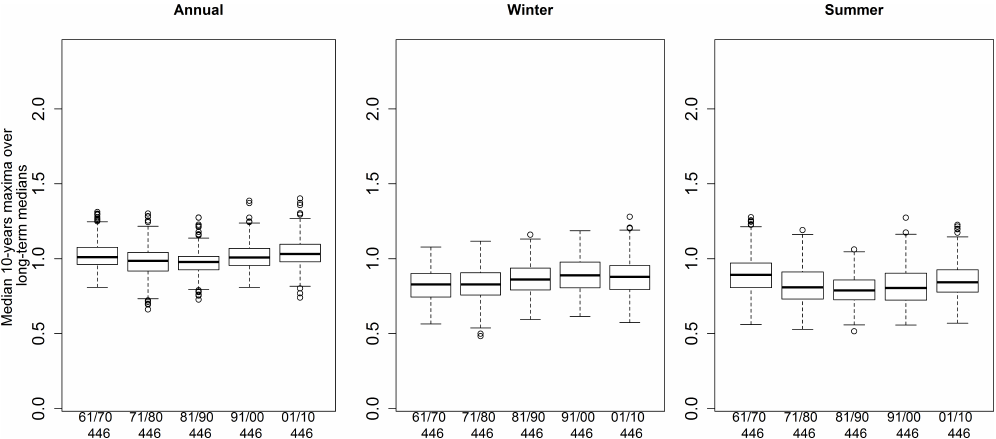
Fig. 5. Median ratio of annual and seasonal maximum rainfall over long-term median of the annual maximum, shown separately for each decade. The number of catchments used to compute the proportions is indicated below the x axis.